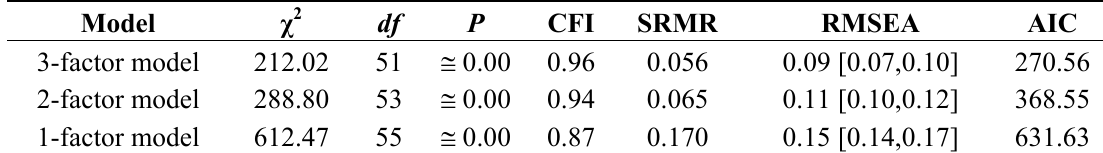
Table 2. Results of confirmatory factor analysis of model testing, second-split sample ( n =